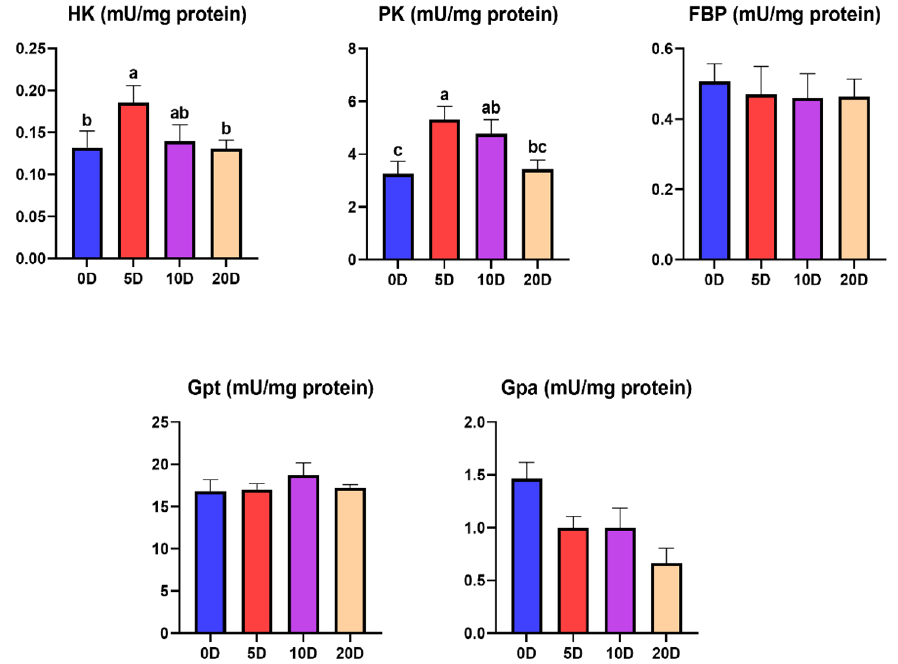
Figure 2. Means ± SEM of enzyme activities ( n = 18 per treatment) related to glycolytic and glycogenolysis metabolism in muscle. a, b, c Different letters indicate significant differences between pre-slaughter times ( p < 0.05). HK: hexokinase; PK: pyruvate kinase; FBP: fructose 1.6-bisphosphatase; GPt: total glycogen phosphorylase; GPa: activated glycogen phosphorylase. Transformation data for parameters when performing analysis of variance: Gpa (square root). In the transformed variables, the SEM are presented for the transformed data and means are presented as back-transformed for better